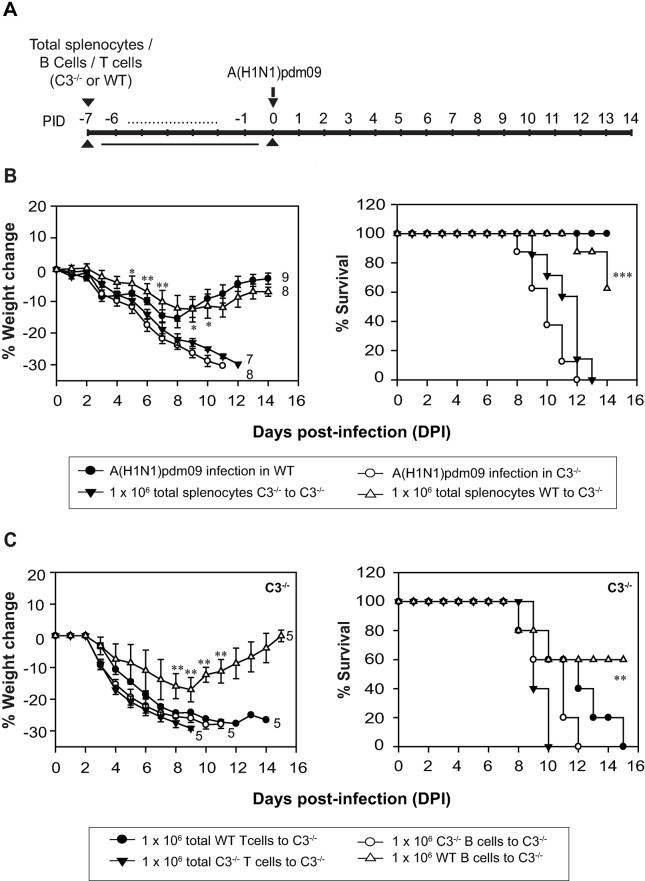
Adoptive transfer of WT splenocytes or purified B cells to C3-/- mice restores protection against the pandemic influenza virus infection.A) Schematic diagram showing the experimental setup. C3-/- mice on C57BL/6 background were injected with 1 X 106 splenocytes or purified T cells or B cells (WT or C3-/-) via tail vein at day minus 7 pre-infection. Thereafter, they were infected intranasally with 450 TCID50 of the virus and monitored for body weight loss and survival for 14 days post-infection. Control mice did not receive splenocytes. B) Adoptive transfer of splenocytes. Left panel, the percentage of body weight loss during the infection in mice receiving WT or C3-/- splenocytes. Body weight was normalized to their initial weight. The number of animals utilized in each group is shown at the end of the line for that group. WT splenocytes to C3-/- mice versus C3-/- splenocytes to C3-/- mice: *p < 0.05 and **p < 0.02. Right panel, the percentage of survival during the infection in C3-/- mice receiving WT or C3-/- splenocytes. Results represent mean ± SEM of two independent experiments. WT splenocytes to C3-/- mice versus C3-/- splenocytes to C3-/- mice: ***p < 0.001. C) Adoptive transfer of purified splenic T or B cells. Left panel, percentage of body weight loss during the infection in C3-/- mice receiving either T or B cells (WT or C3-/-). Body weight was normalized to their initial weight. The number of animals utilized in each group is shown at the end of the line for that group. WT B cells to C3-/- mice versus C3-/- B cells to C3-/- mice: **p < 0.02. Right panel, percentage of survival during the infection in C3-/- mice receiving either T cells or B cells (WT or C3-/-). WT B cells to C3-/- mice versus C3-/- B cells to C3-/- mice: **p < 0.02.